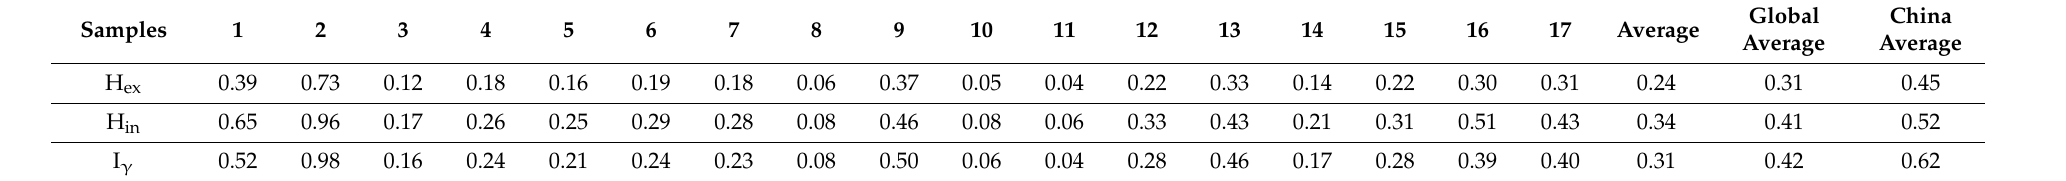
Table 6. H ex , H in , and I γ of 226 Ra, 232 Th, and 40 K in the 17 mining